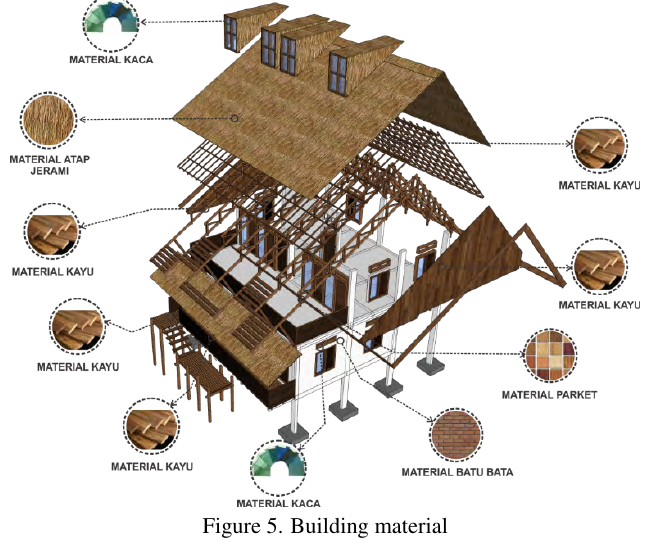
Figure 5. Building